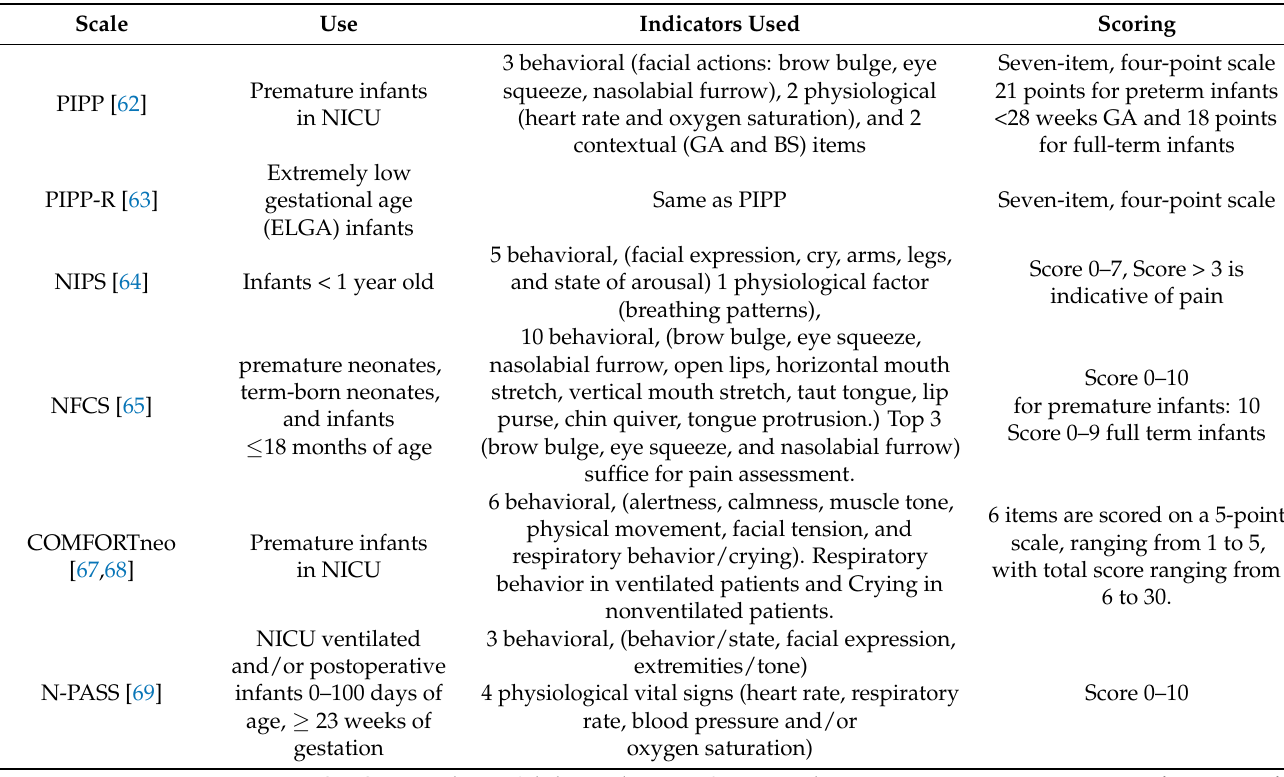
Table 1. Most used Pain Scales in Infants and the